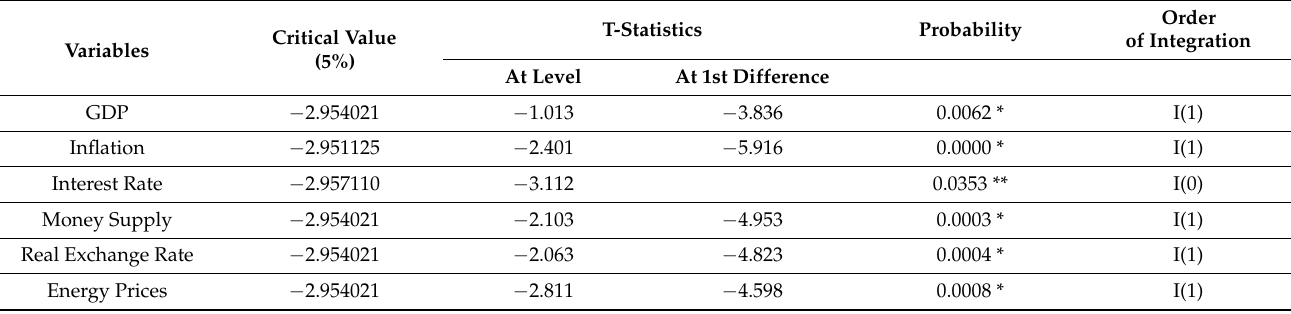
Table 2. Stationarity